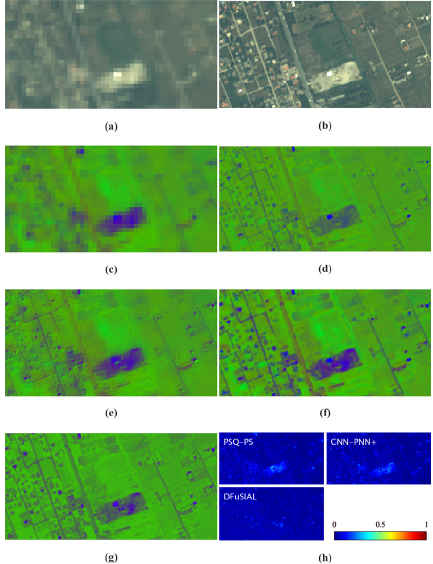
Figure 17. Zoom-in on the abundance fraction maps for three dominant EMs in the selected area for Test 6. ( a , b ) present RGB composites of the Ikonos in reduced and original SR of 7.36 m and 1.84 m, respectively. ( c , d ) present corresponding fraction maps as obtained using the spectral images with LSR 13.12 m and HSR 3.28 m (used as GT), respectively. ( e – g ) present corresponding fraction maps with HSR 1.84 m, as obtained using the images retrieved by the PSQ-PS and CNN-PNN + methods and as obtained by the proposed fusion method DFuSIAL, respectively. ( h ) present the corresponding area in the MAE maps of the fractions obtained by the examined methods.